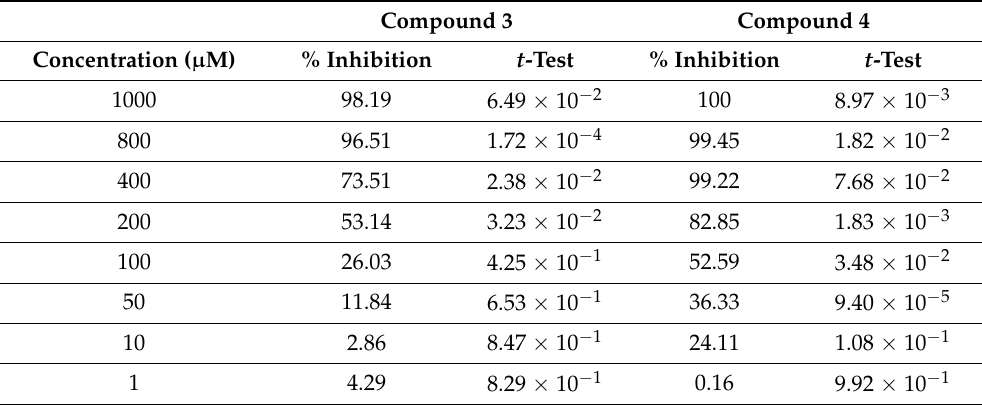
Table 1. Dose-dependent inhibition of P19 cells exposed to compounds 3 and 4 (Student t -test, 2 tails,